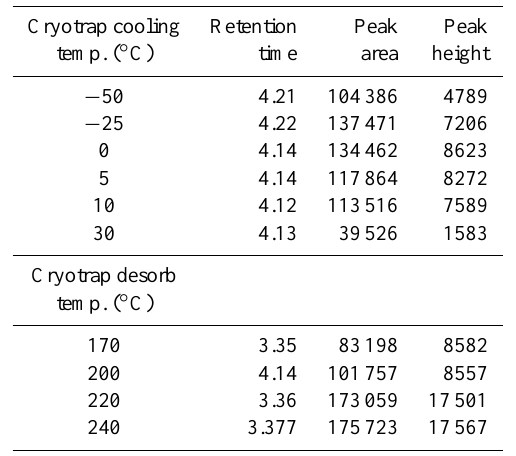
Table 2. GC/MS results from permeation of HgBr 2 with varying cryotrap cooling and desorption temperatures. Each iteration was performed at least in duplicate to verify the consistency of results. Peak area and height are for m/z 362.